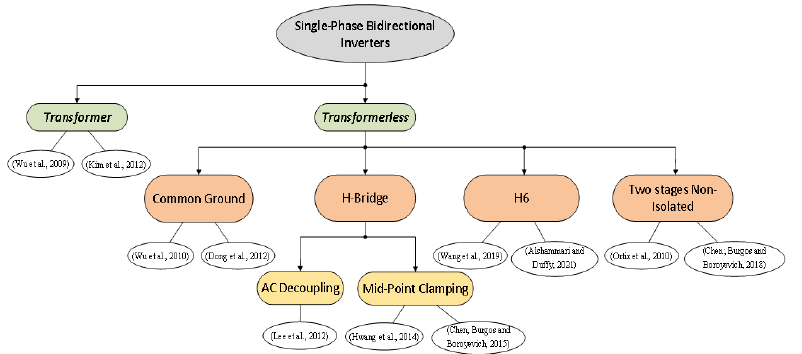
Figure 4. Classification of single-phase bidirectional inverter topologies integrated with a DC dis- tribution system. (We et al., 2009) — [63]; (Kim et al., 2012) — [51]; (Wu et al., 2010) — [52]; (Dong et al., 2012) — [44]; (Lee et al., 2012) — [43]; (Hwarg et al., 2014) — [39]; (Chen, Burgos and Boroyevich, 2015) — [56]; (Wang et al., 2019) — [53]; (Alshammari and Duffy, 2021) — [54]; (Ortiz et al., 2010) — [64]; (Chen, Burgos and Boroyevich, 2018) —